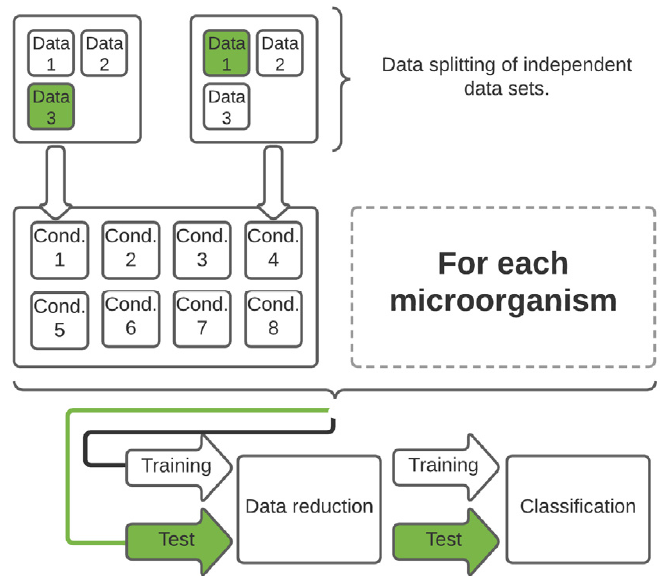
Figure 1. The data splitting, reduction and classification are depicted in this diagram. The corre- sponding information about the measured microorganisms, stress conditions, and storage times can be found in the training and test data set.